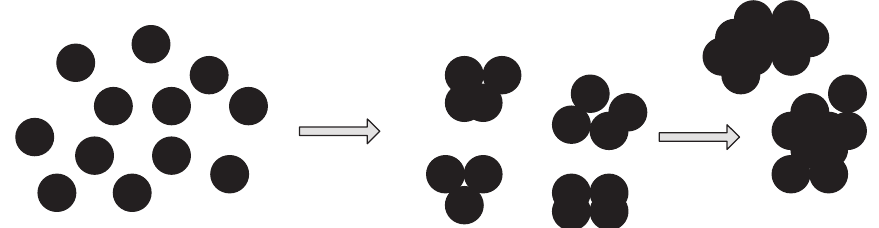
Figure 2: Changes of urine microcrystalline aggregates in the experimental group.